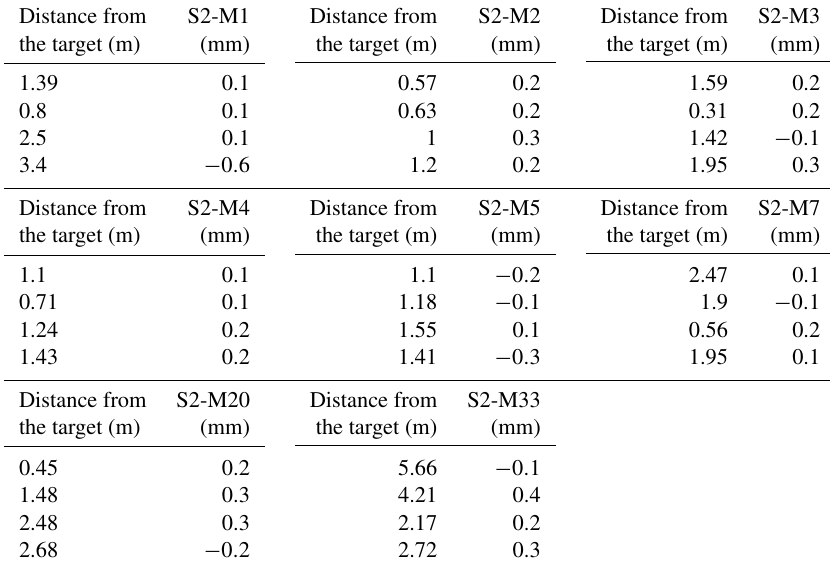
Table 6. Horizontal error propagation with distance from the control target in DEMs from the field. Distance from